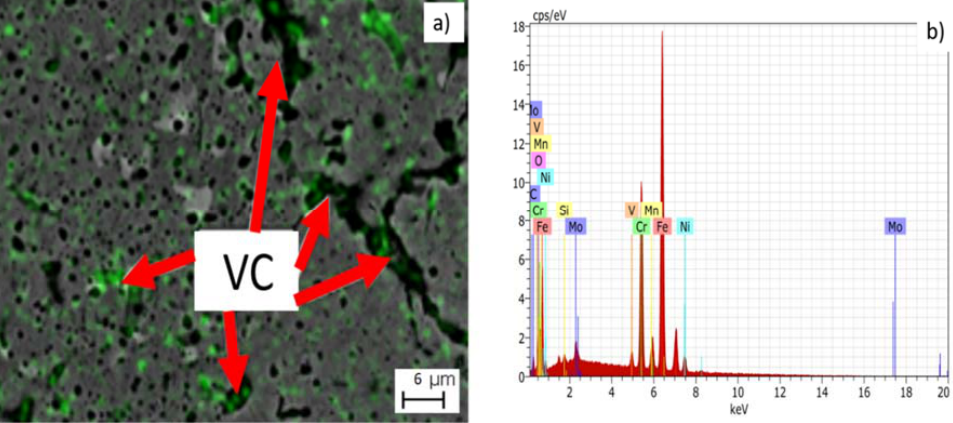
Figure 6. ( a ) Distribution of vanadium particles (green) on stainless–steel particles. ( b ) EDS spectrum of 3% VC added stainless–steel.